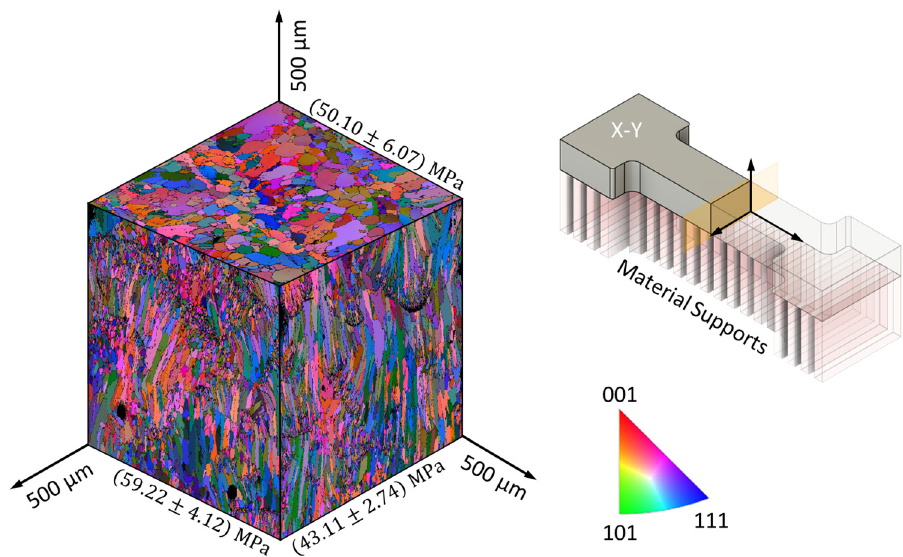
Figure 5. Grain pattern appearance in 3D-printed RS-333 Al alloy—the XY printing orientation. Youngs’ modulus values derived from nanoindentation measurements are shown at the respective planes.